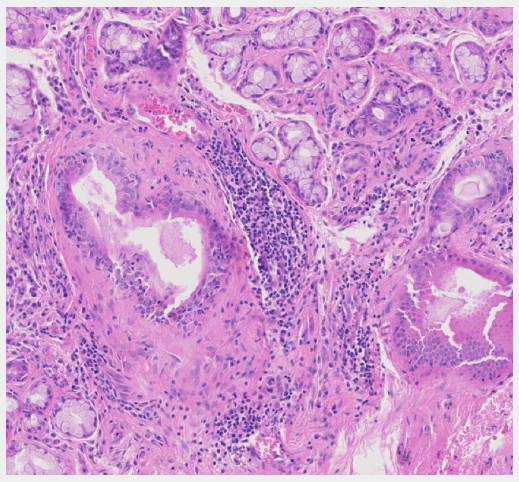
Immunohistochemistry staining for CD20 and CD3 in sequential sections of a labial salivary gland sample showing a large, segregated focus with a predominant B cell